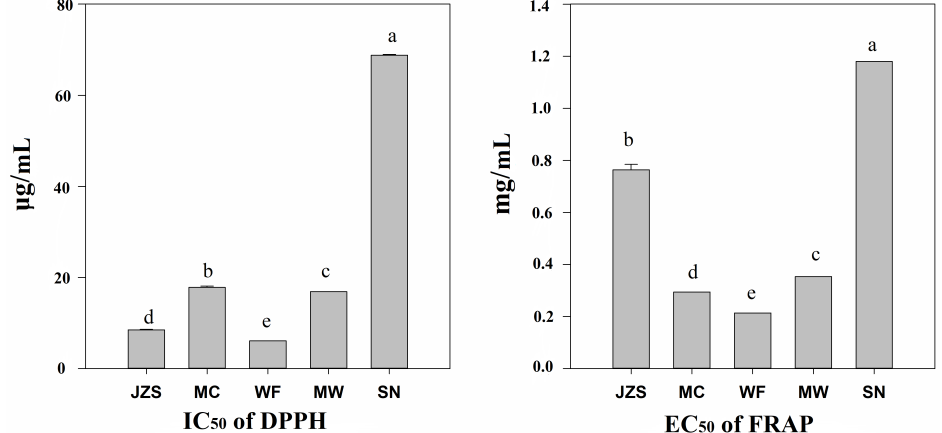
Figure 3. Antioxidant activities of C. paliurus phenolics from different locations (JZS, MC, WF, MW, and SN) in vitro, using two different testing systems. Different letters indicate significant differences ( p < 0.05) between locations.